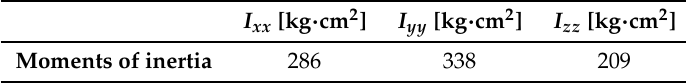
Figure 7. Impact test scheme. Table 7. Moments of inertia of the headform.